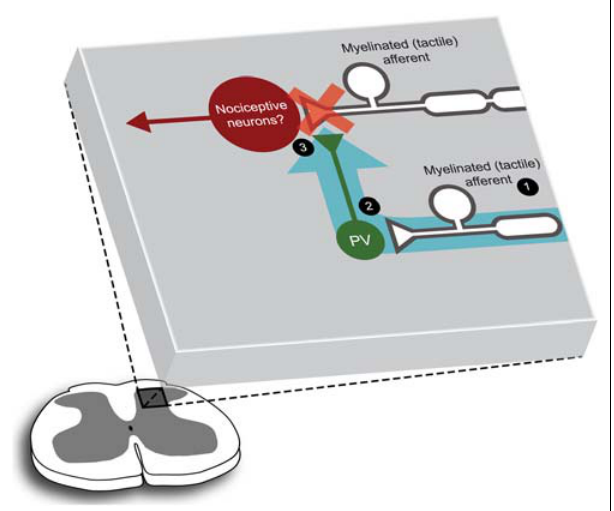
FIGURE 1 | Parvalbumin-positive DH neurons are configured to mediate presynaptic control of myelinated afferent fiber that contribute to DH circuits. Figure summarizes a characterization of PV-positive neurons using a GFP expressing transgenic mouse line (Hughes etal., 2012). PV-positive DH neurons and their axonal arbors (2, green) are concentrated in lamina IIi/III.These cells receive input from myelinated (tactile) primary afferents (1), and their axons appear to target the central terminals of myelinated primary afferents preferentially, forming inhibitory axoaxonic synaptic inputs (3).Thus, when this microcircuit is activated (blue arrow) myelinated afferent input is inhibited, or gated (red cross).The downstream target of this PV-gated input remains to be identified, however, the location of these connections suggests that neurons in nociceptive circuits may be